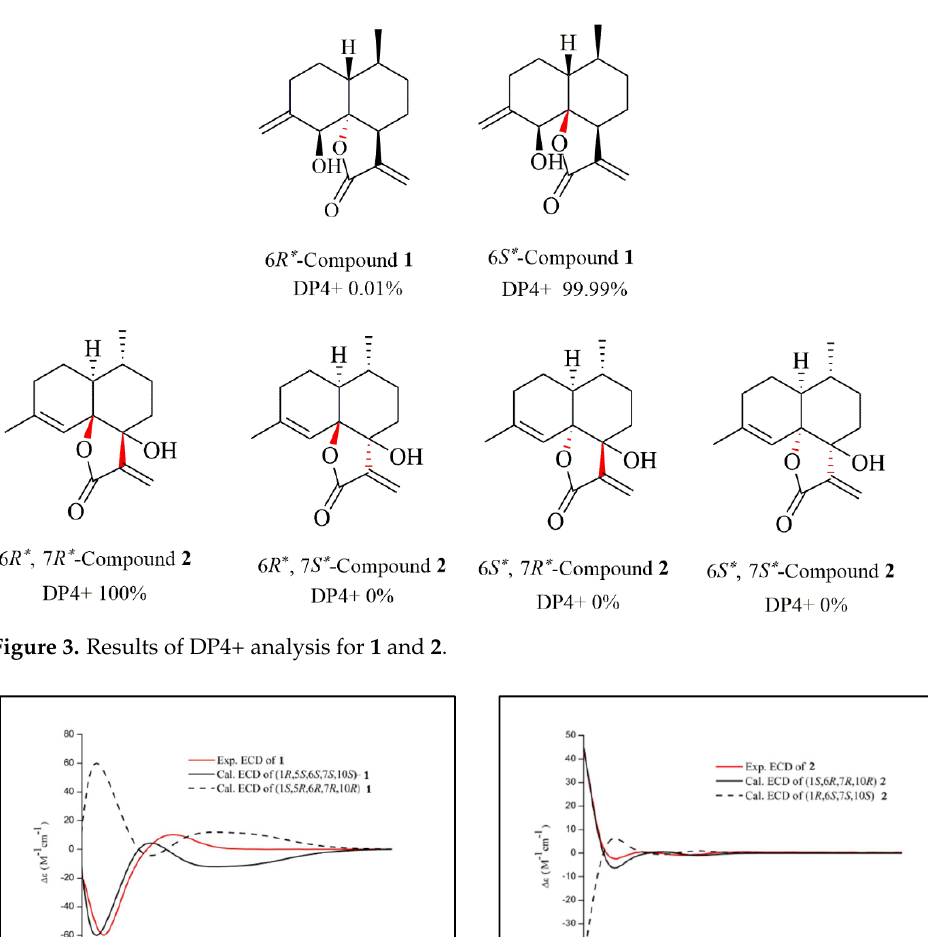
Figure 4. Experimental ECD spectra for compounds 1 and 2 .